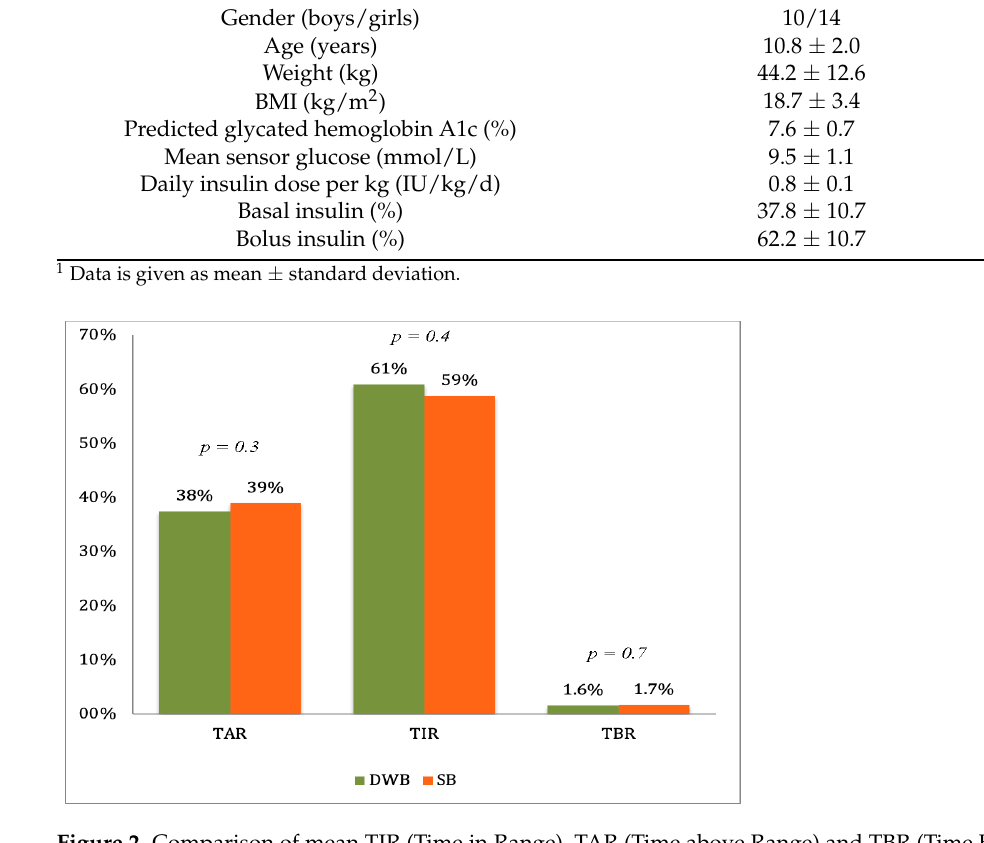
Figure 2. Comparison of mean TIR (Time in Range), TAR (Time above Range) and TBR (Time